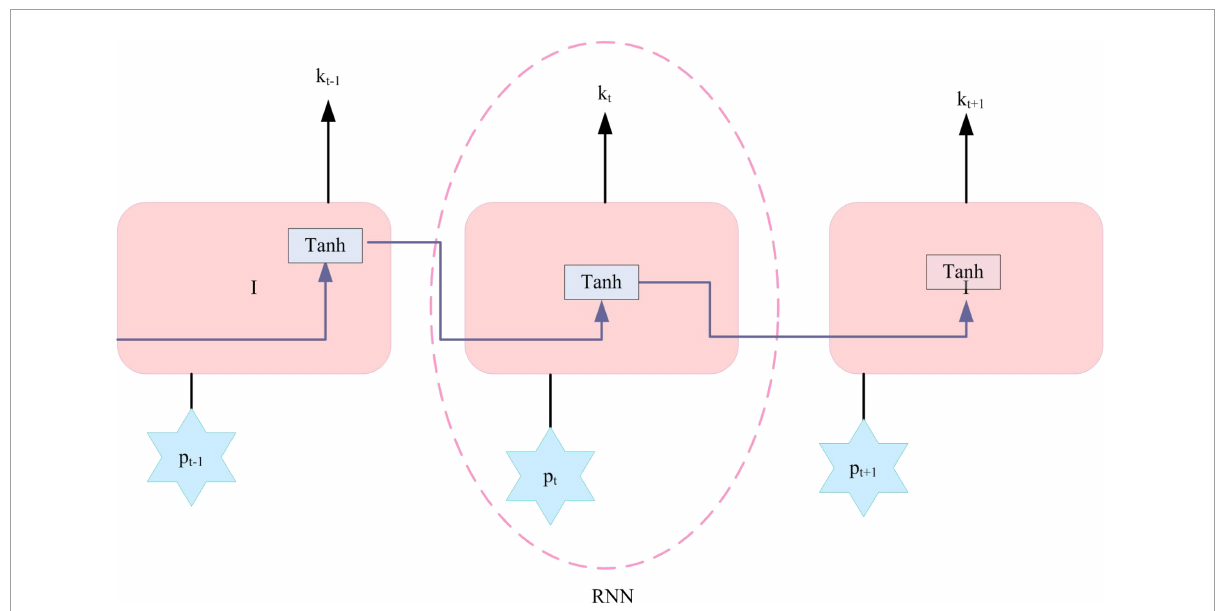
FIGURE4 Network structure of a standard recurrent neural network